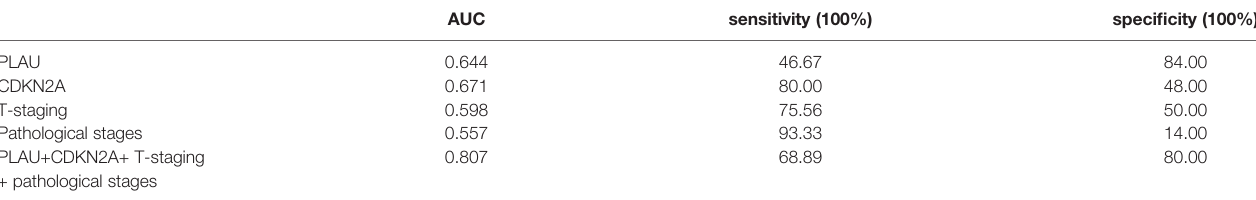
TABLE 4 | Value analysis of prediction model in prospective